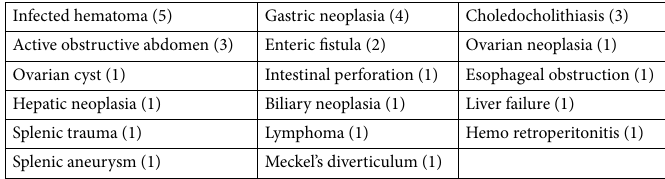
Table 1. Other diagnosis (number of